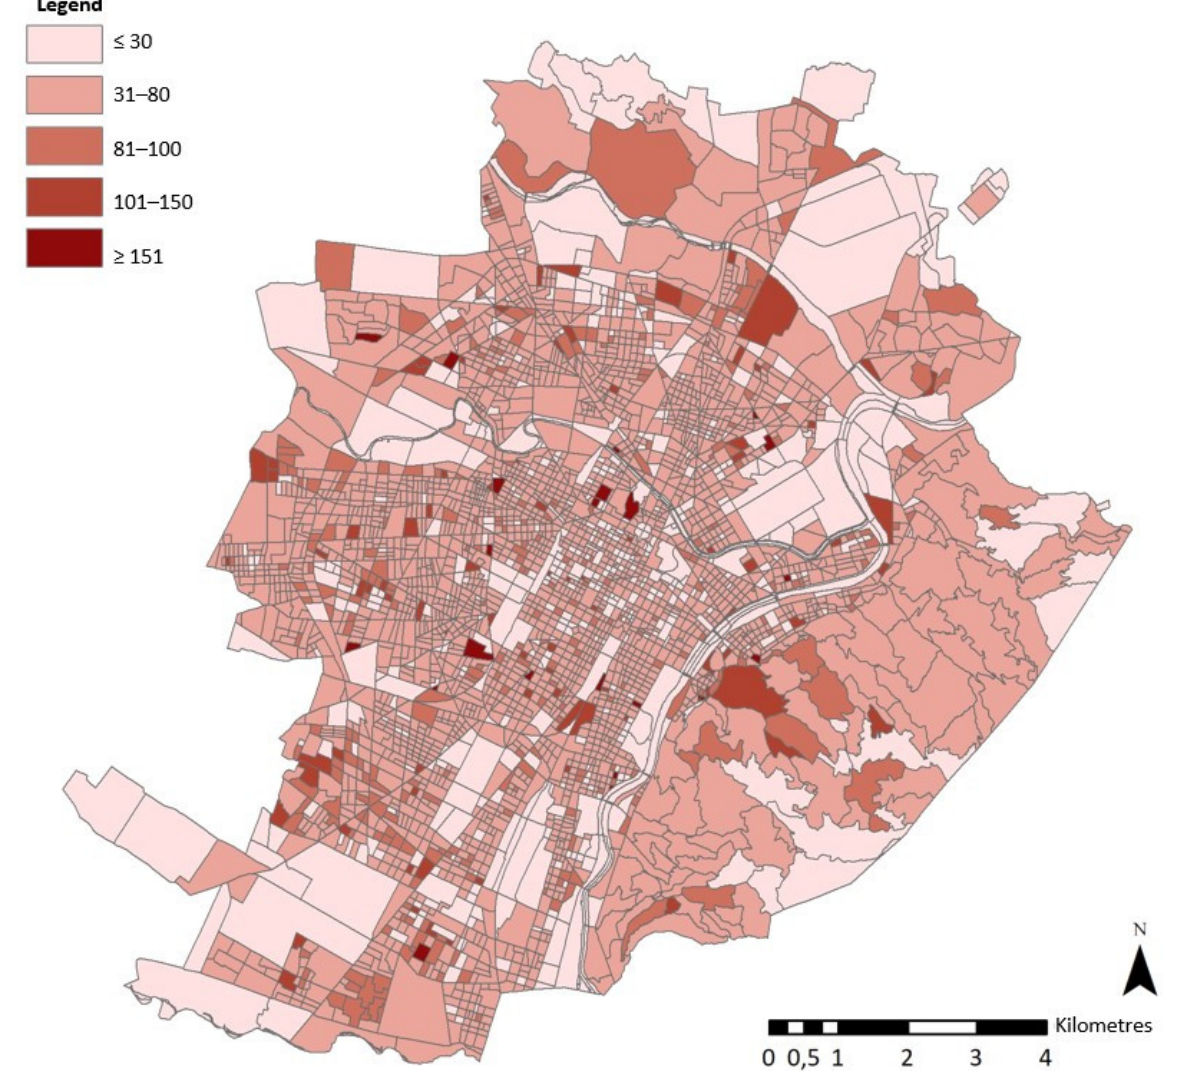
Figure 10. Dependency ratio, year 2020 [29].